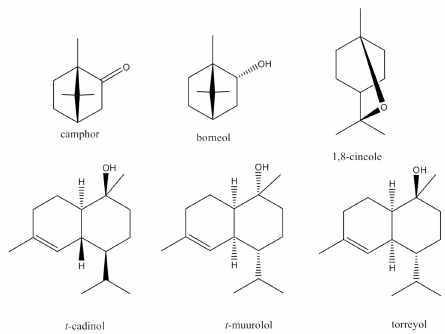
Figure 2. The chemical structures of camphor, borneol, 1,8-cineole, t -cadinol, t -muurolol, and torreyol.